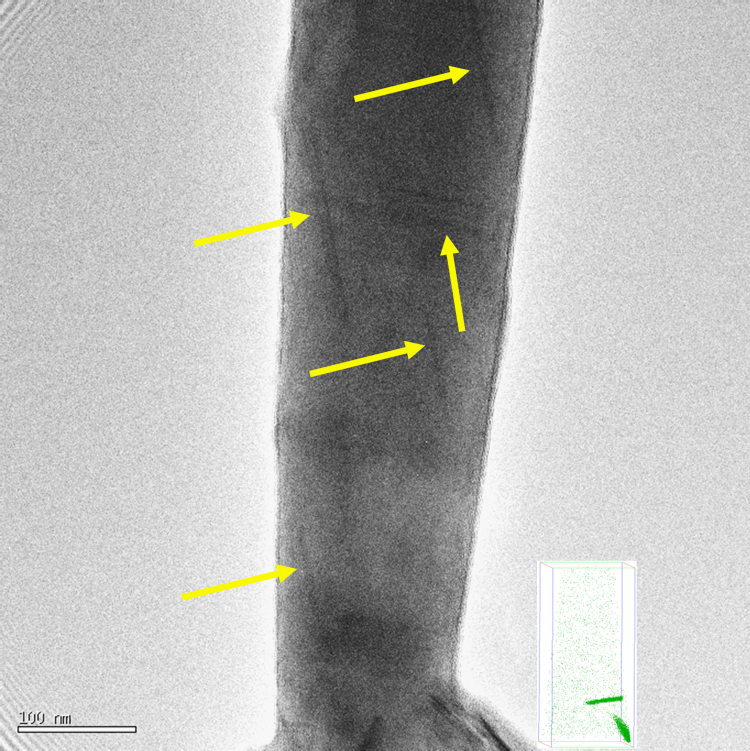
TEM image of APT specimen heat treated for 1 min at room temperature and 580 h at 453 K. The yellow arrows indicate elongated B′ precipitates. The inset is a LAR-3DAP measurement of the same material at the same magnification, but not the same area of analysis.